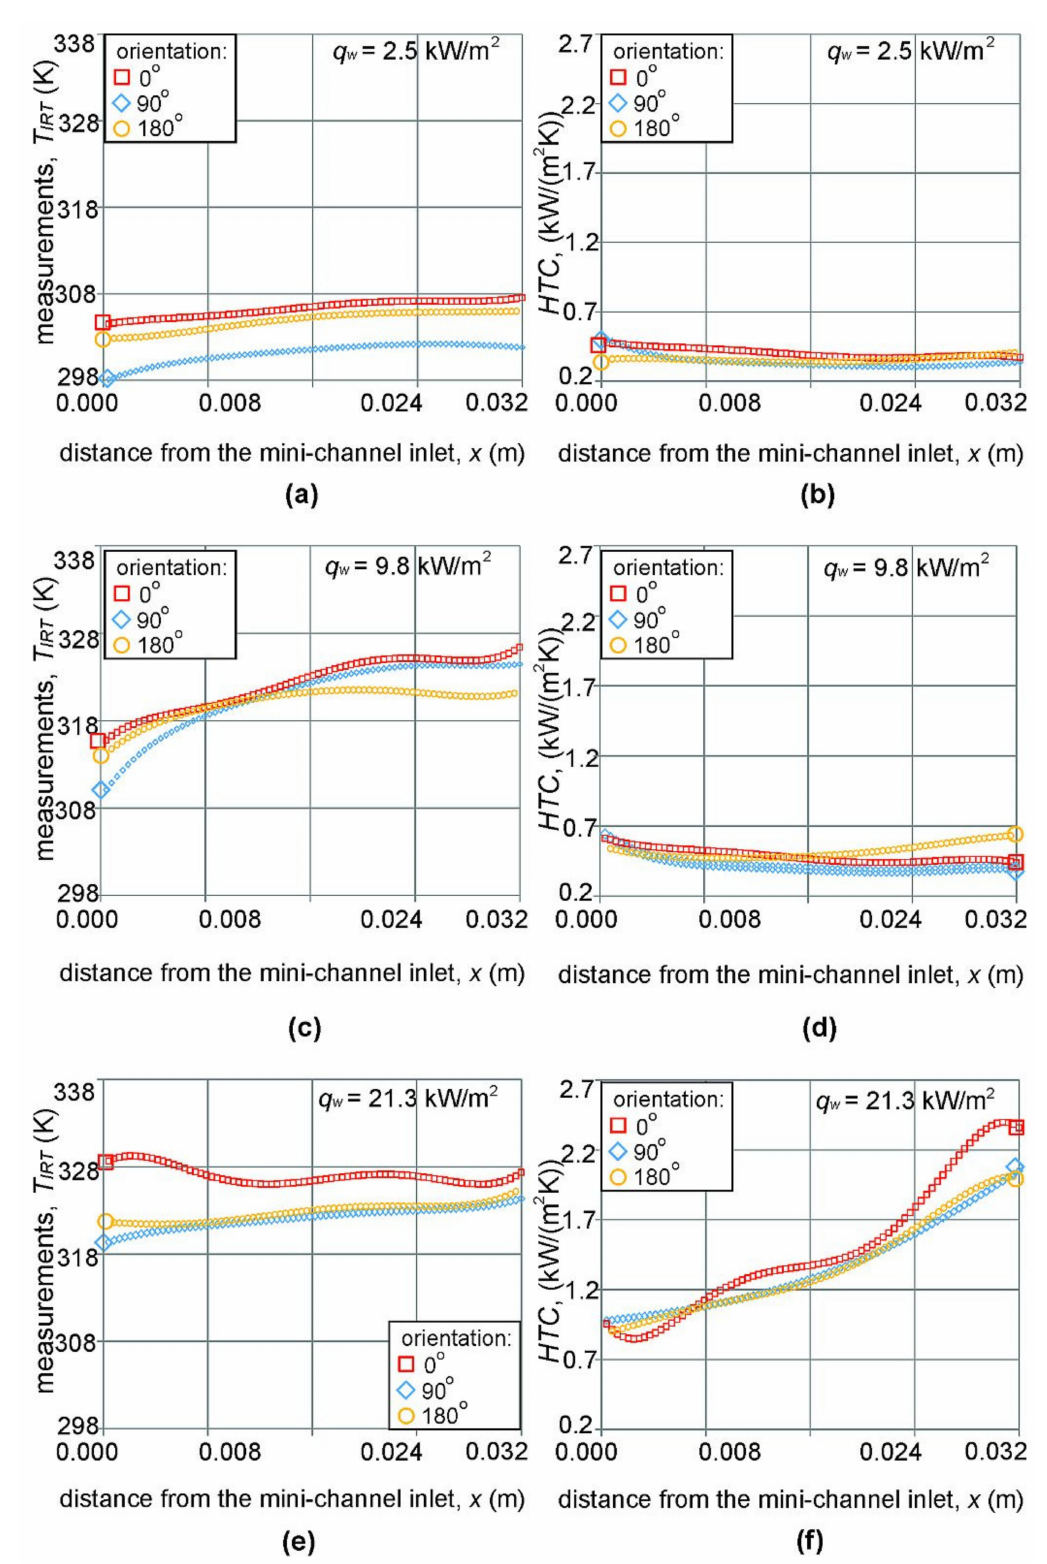
Figure 9. Plate temperature measurements using the IR camera ( a , c , e ) and heat transfer coefficient ( b , d , f ), both vs. distance from the mini-channel inlet; subcooled boiling region; three spatial channel orientations (0 ◦ , 90 ◦ and 180 ◦ ); mass flux of 440 kg/(m 2 · s), smooth heated plate; FC-72; L IRT = 32